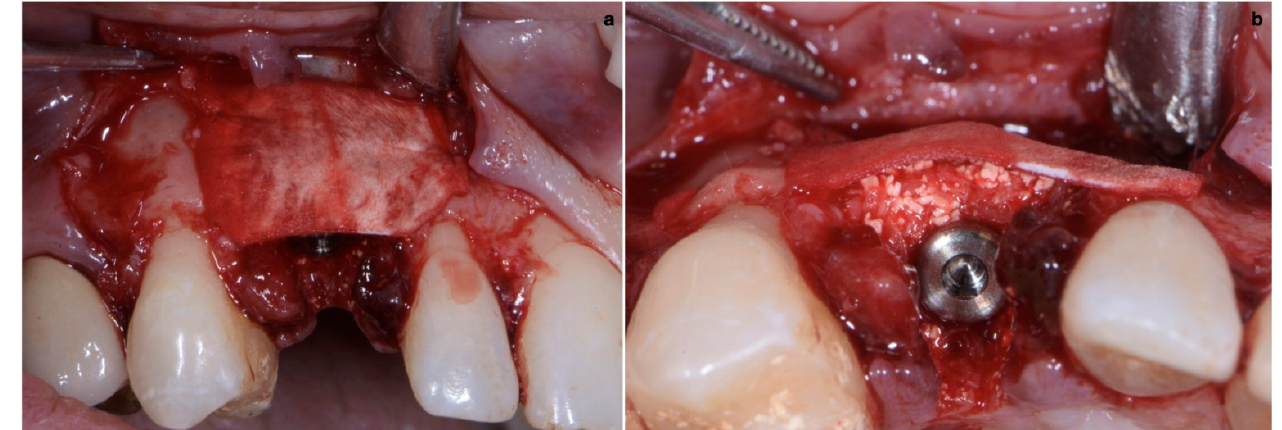
Figure 8. ( a , b ) Biomaterial stabilized by a thin pericardium membrane placed between bone particles and connective-tissue graft.